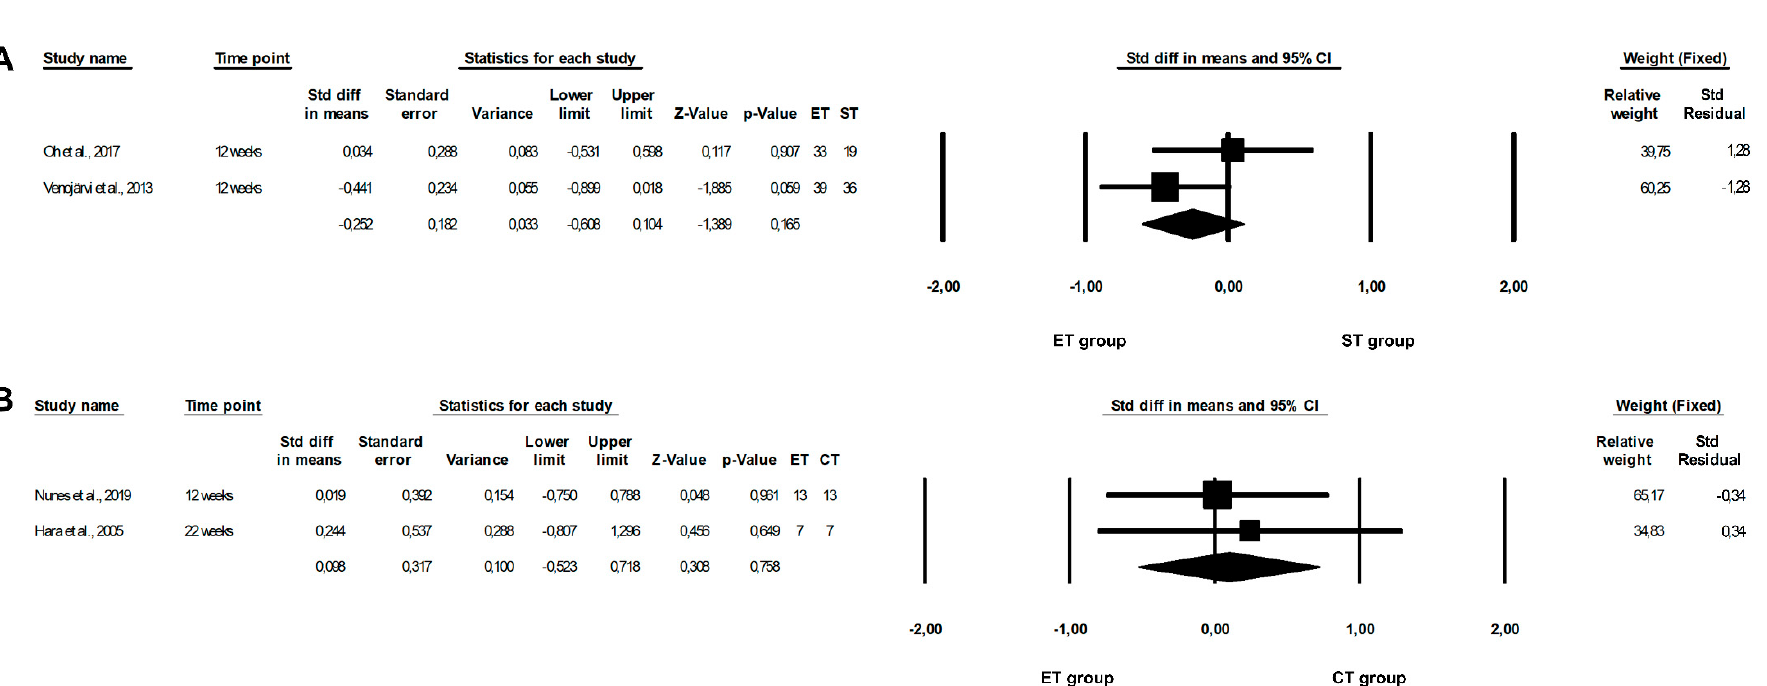
Figure 5. Forest plots of the effect of different training programmes on leptin levels: ( A ) ET vs. ST—fixed model; ( B ) ET vs. CT—fixed model. CI—confidence interval; CT—combined training; ET—endurance training; ST—strength training; Std diff—standard differences [19,40,45,47].